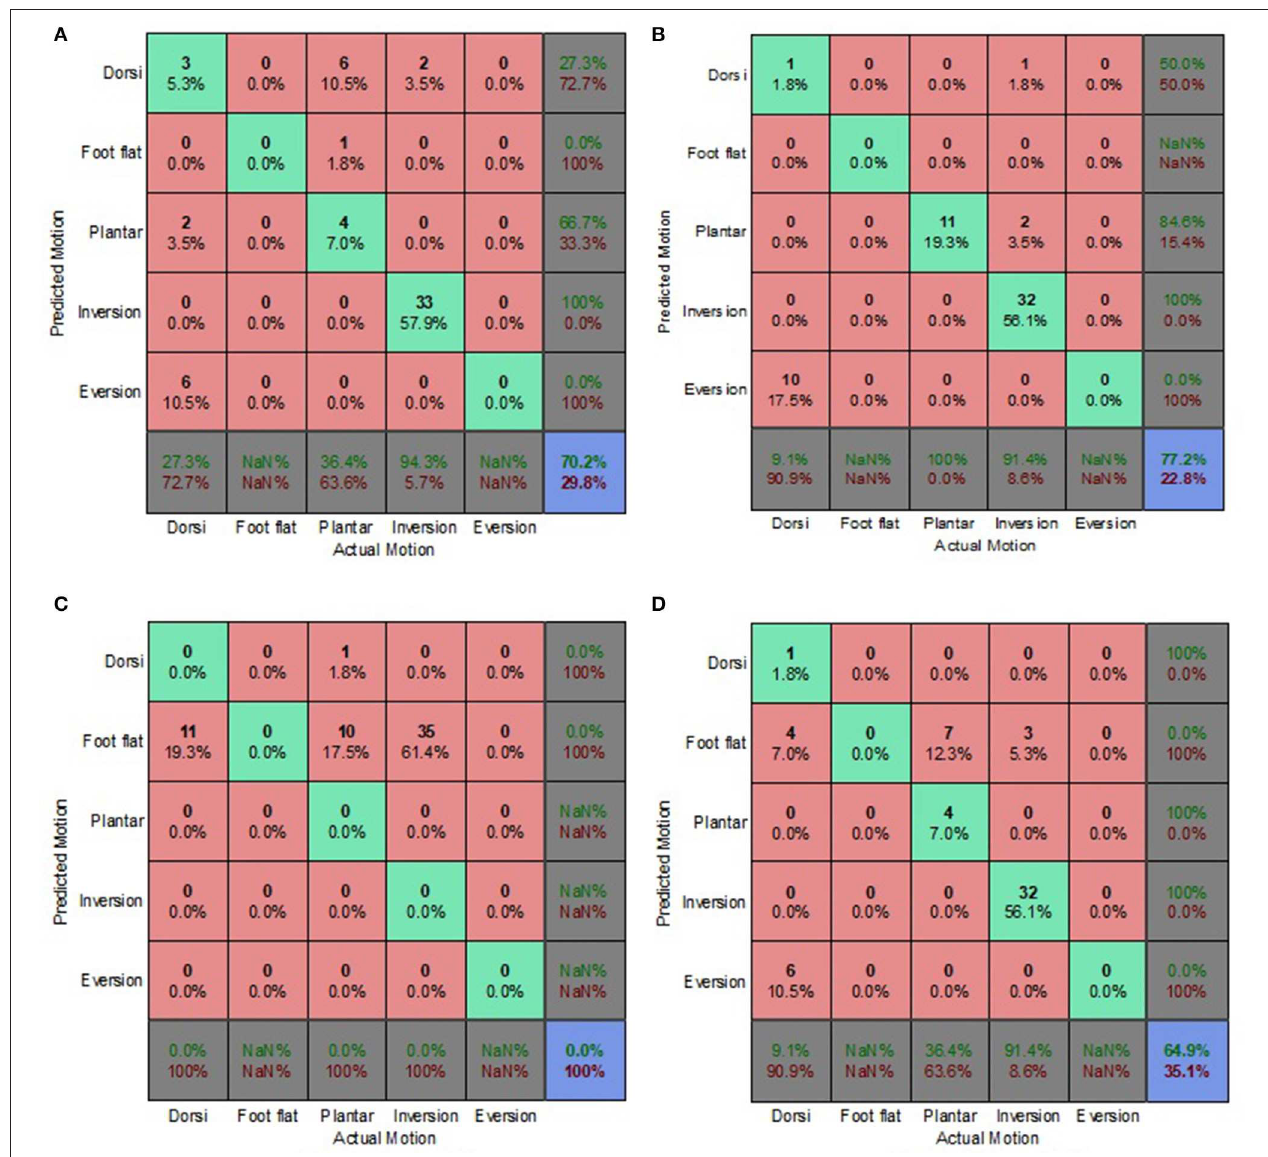
FIGURE 10 | Optimal Condition Decoupled Data Set—UT Generic Approach. (A) Tree, (B) LDA, (C) Deterministic, and (D) Voting